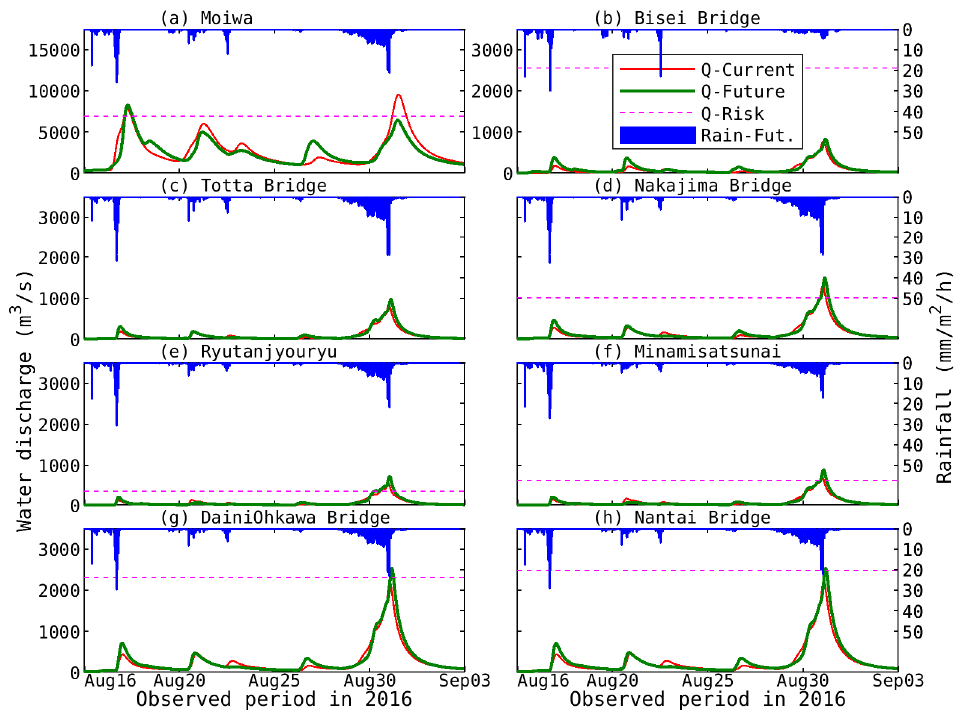
Figure 8. Discharge comparison between the current flood simulation (red line) by the statistical bias-correction and future flood simulation (green line) by the statistical and linear combination bias-correction, with future mean rainfall (blue box) over an upstream area from each gauge station. All other information is identical to that in Figure 5.